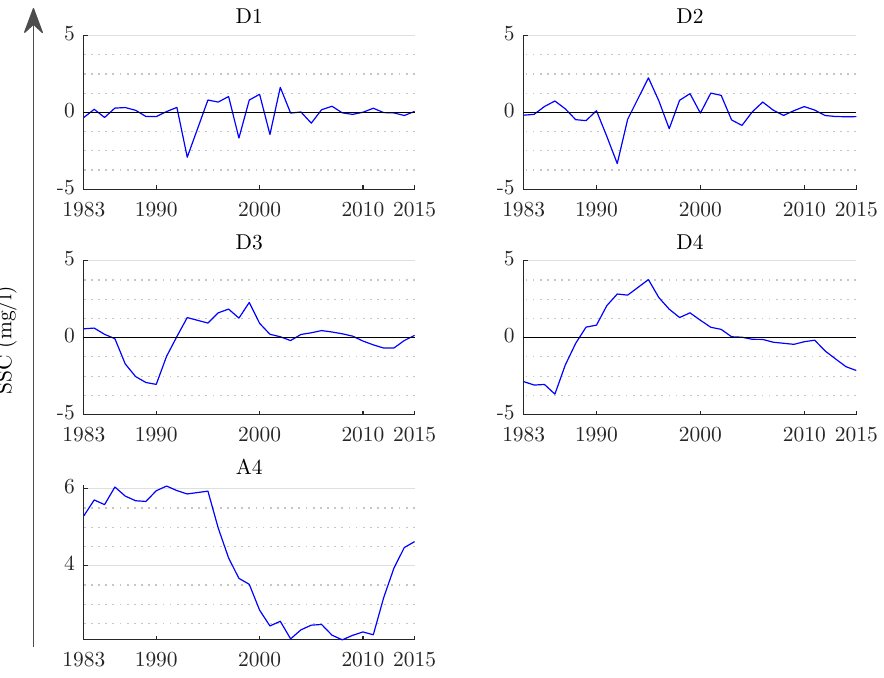
Figure 5. Detailed coefficients of (DW1) two years, (DW2) four years, (DW3) eight years, and (DW4) sixteen years along with the approximation coefficient (A4) of Yugo are